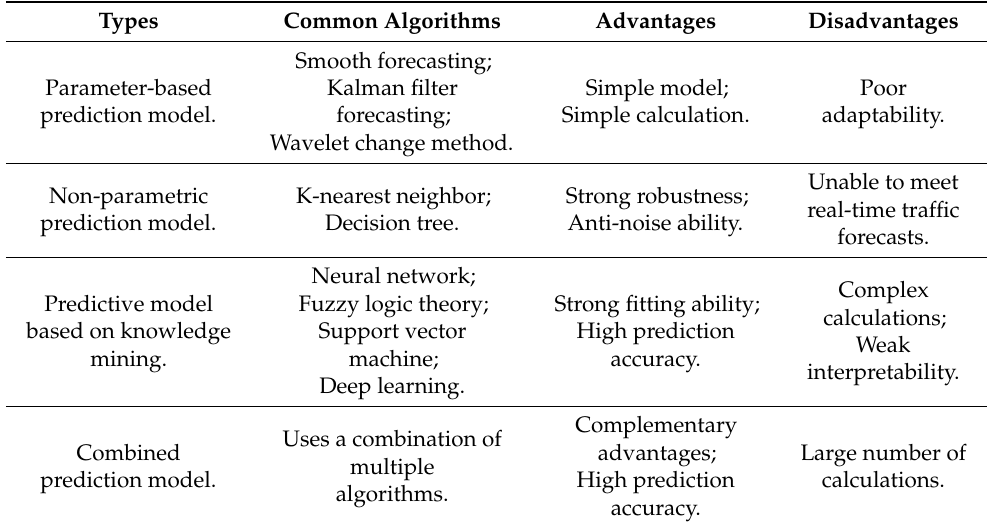
Table 1. The advantages and disadvantages of predictive models and their common